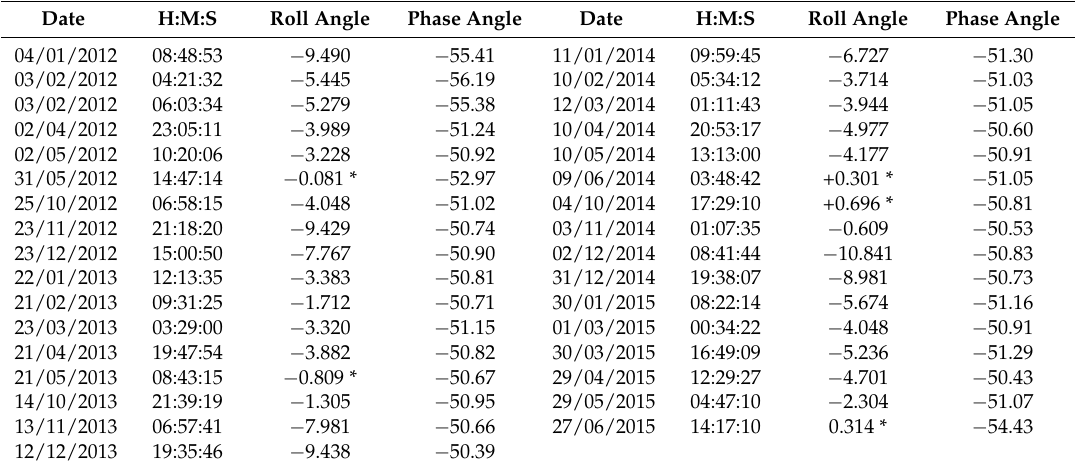
Table 3. S-NPP VIIRS lunar calibrations implemented (launch to September 2015). Angle units are degrees. No satellite roll maneuver was performed if the predicted roll angle is within ˘ 1 degree (denoted with